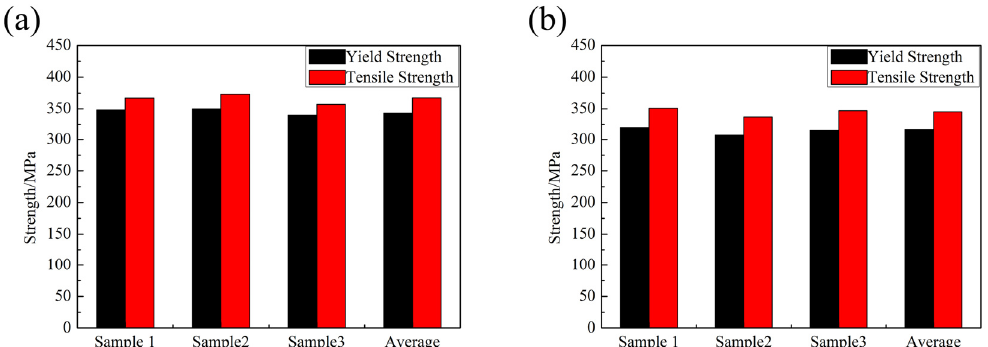
Figure 14. Strength of the samples in different positions: ( a ) flange; ( b ) bottom.